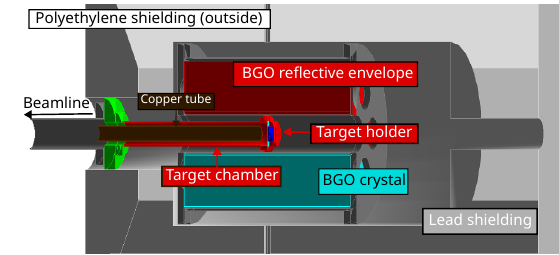
Figure 1. Section of the 3D model of the detector setup used in the Geant4